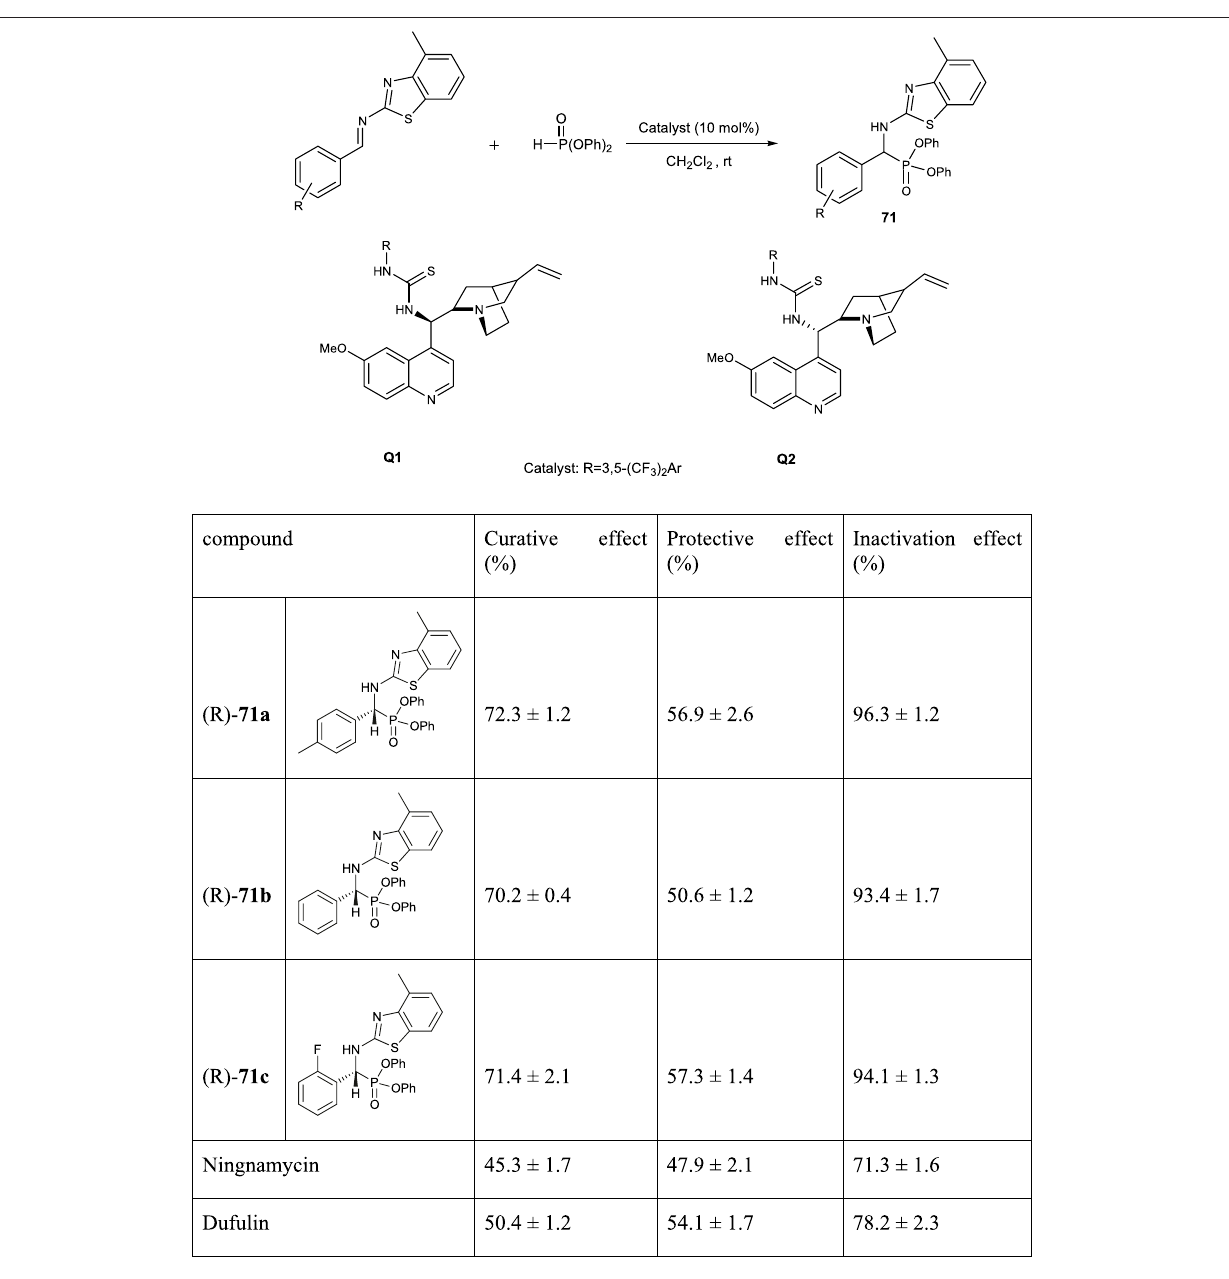
FIGURE 10 | Synthesis and biological activities data of compounds 71